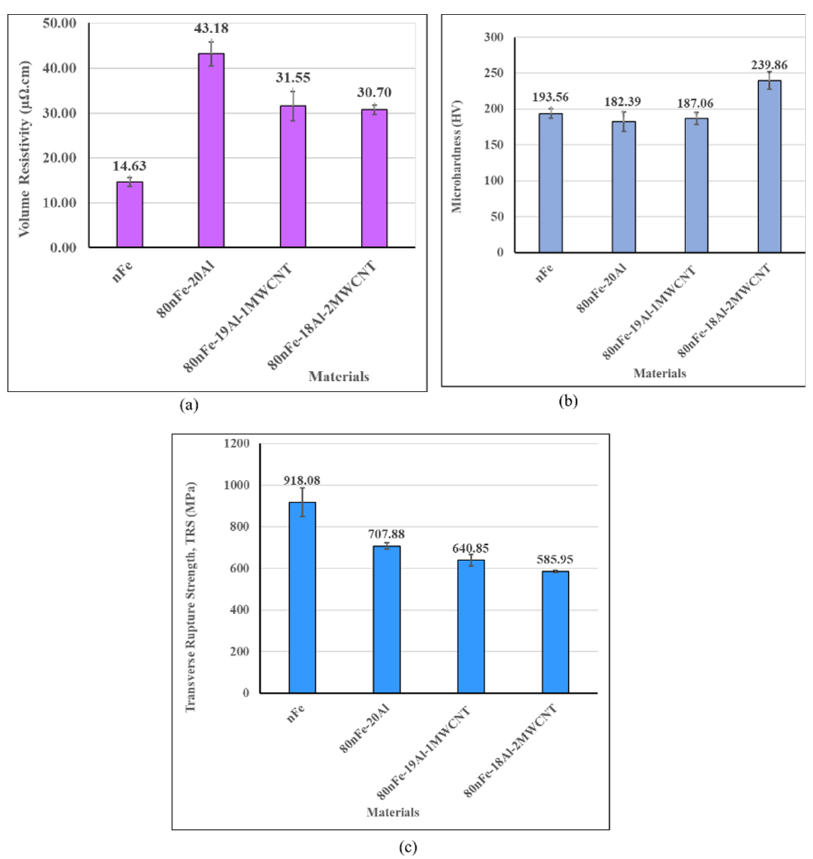
Figure 7. Effect of the MWCNT volume content on the electrical and mechanical properties: ( a ) electric resistivity; ( b ) Vickers microhardness and ( c ) transverse rupture strength.